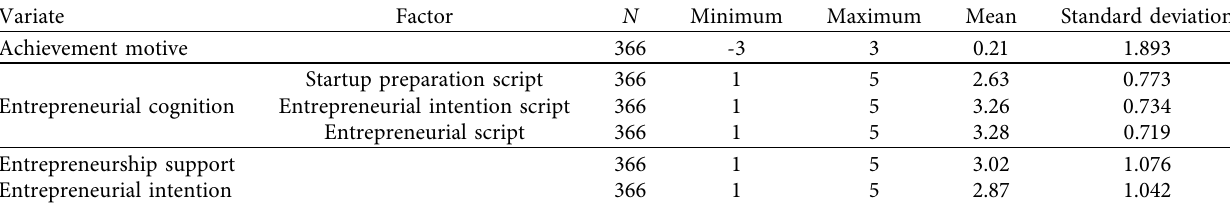
Table 3: Descriptive statistical analysis.